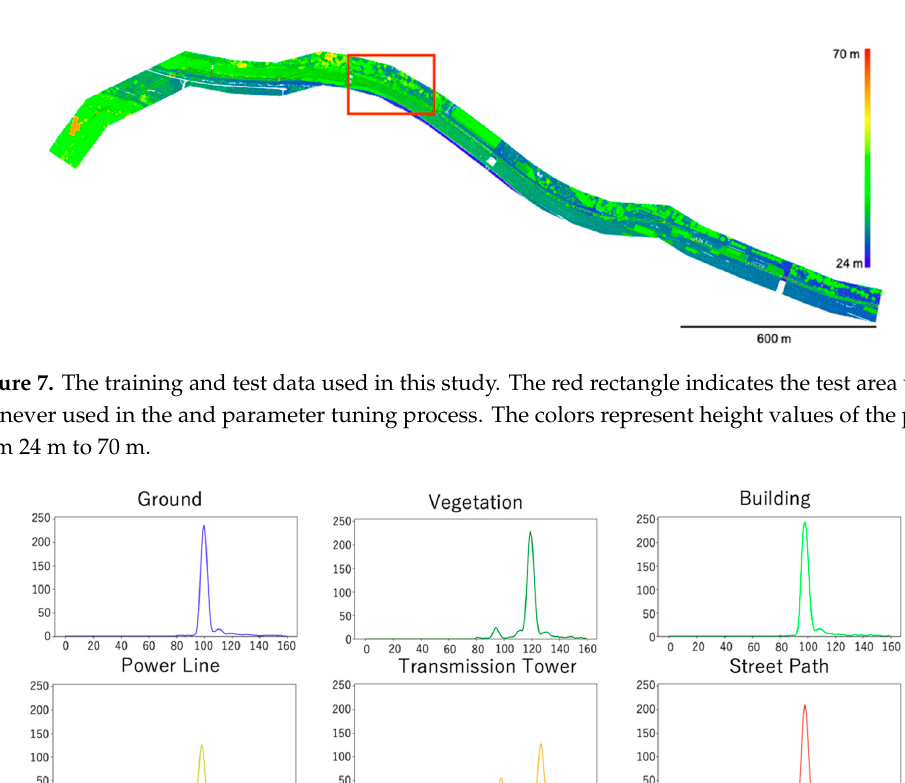
Figure 8. Example of waveforms used in this study. Each visualized waveform is the average value of 100 values randomly extracted from the classes. 100 values randomly extracted from the